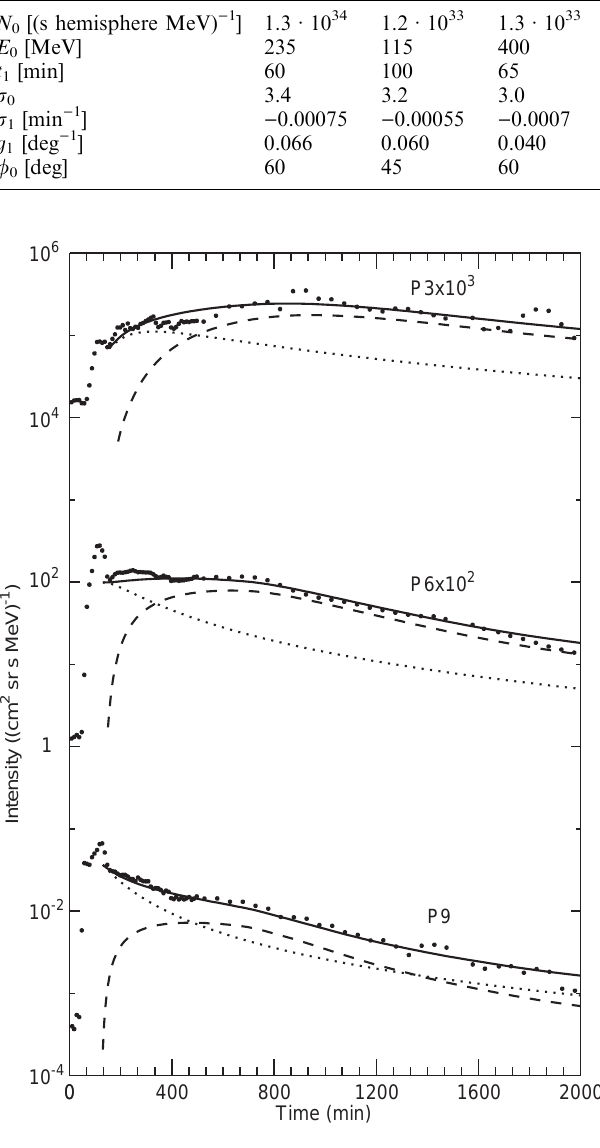
Fig. 4. Observed (GOES-6) and calculated pre-shock count rates of the 24 October 1989 SEP event in proton channels P3, P6 and P9. The symbols are the same as in Fig.